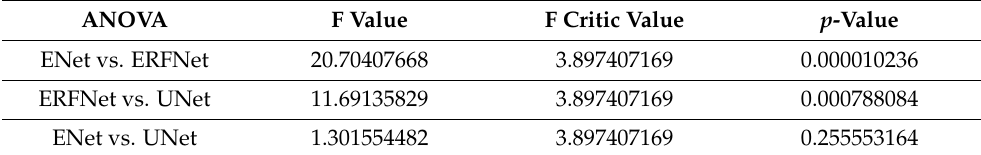
Table 4. ANOVA on the DSC showed statistical differences between segmentation